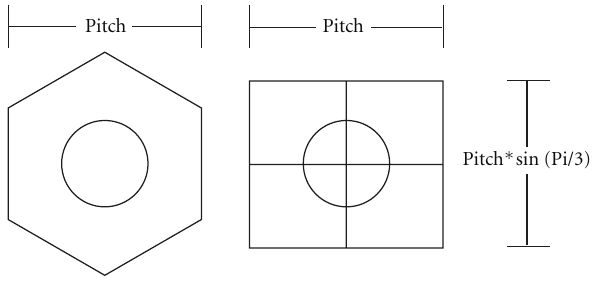
Figure 5: PARCS lattice cell representation.